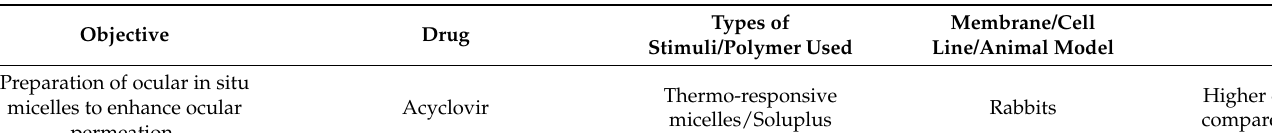
Table 5. Smart ocular delivery using in situ gel approach against ocular